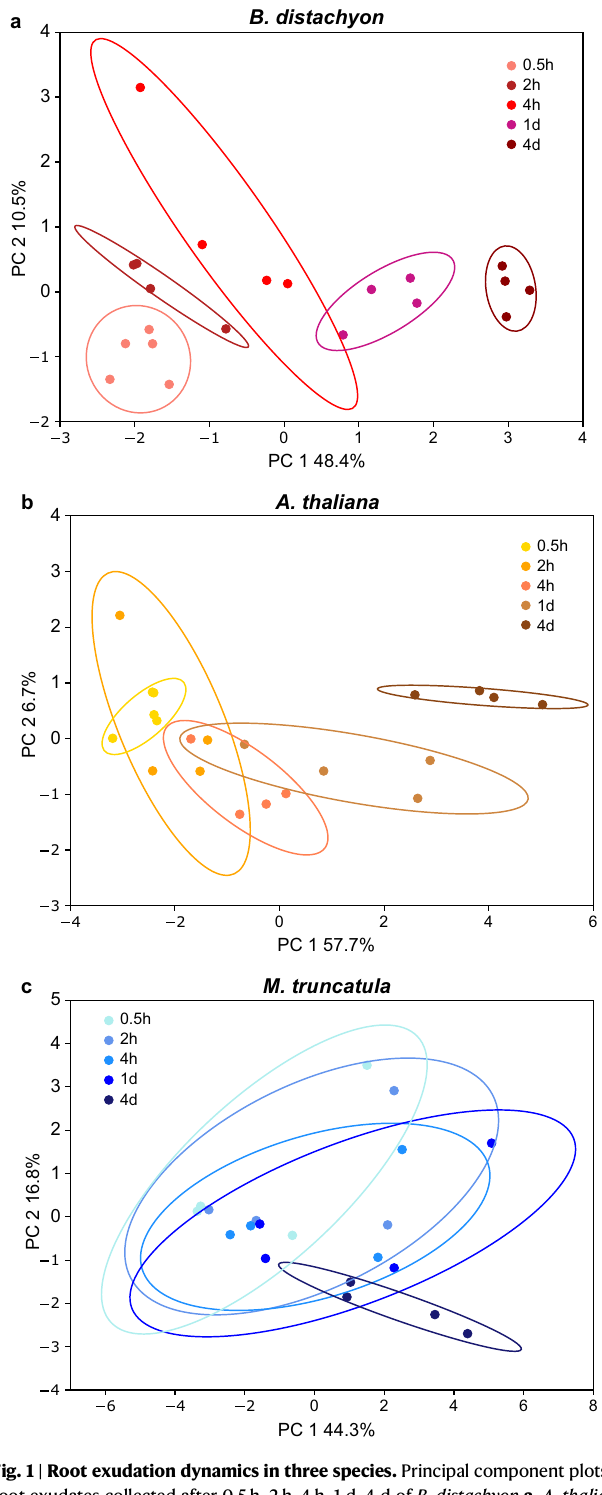
Fig. 1 | Root exudation dynamics in three species. Principal component plots of root exudates collected after 0.5h, 2h, 4h, 1 d, 4 d of B. distachyon a , A. thaliana b ,and M.truncatula c .DetailsofthisdatasetaregiveninSupplementaryFigs.2and 3. Total number of metabolites: 63. Number of jars with 3 – 5 plants: 3 – 4 for each timepoint. One representative experiment out of three total is